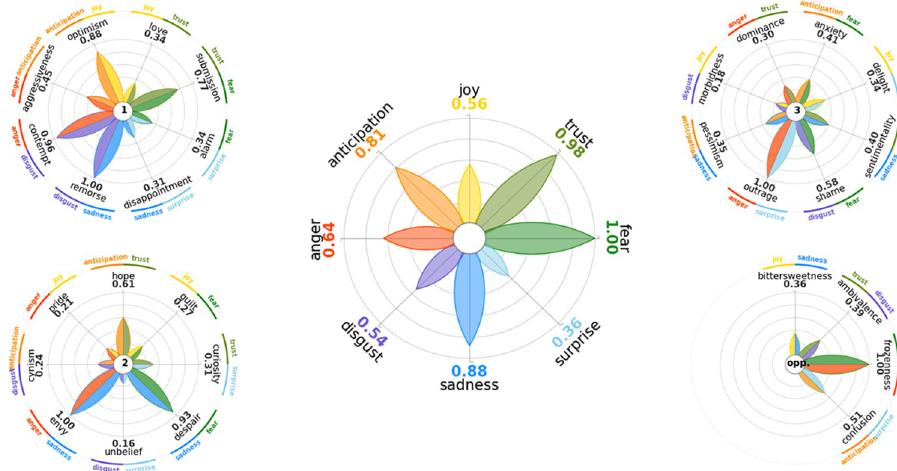
Fig 2. Plutchik’s wheels of emotions. The central wheel shows basic emotions, the wheel in the upper left corner shows primary dyads, the wheel in the lower left corner shows secondary dyads, the wheel in the upper right corner shows tertiary dyads, and the wheel in the lower right corner shows